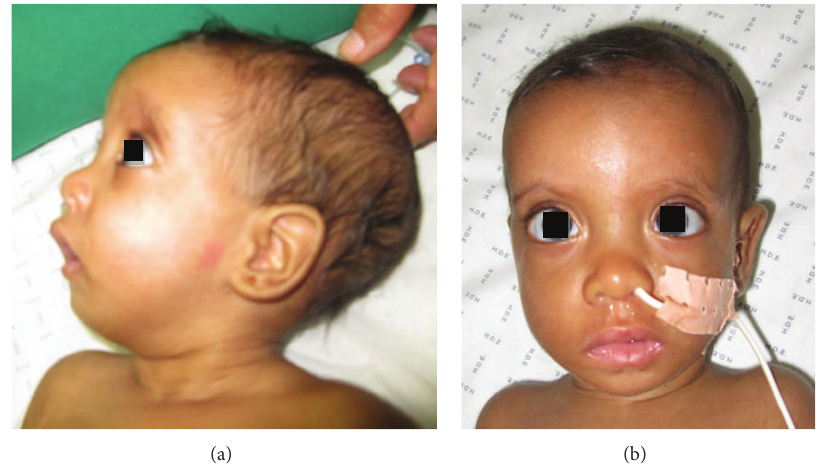
Figure 2: Lateral (a) and frontal (b) view of face and neck of the